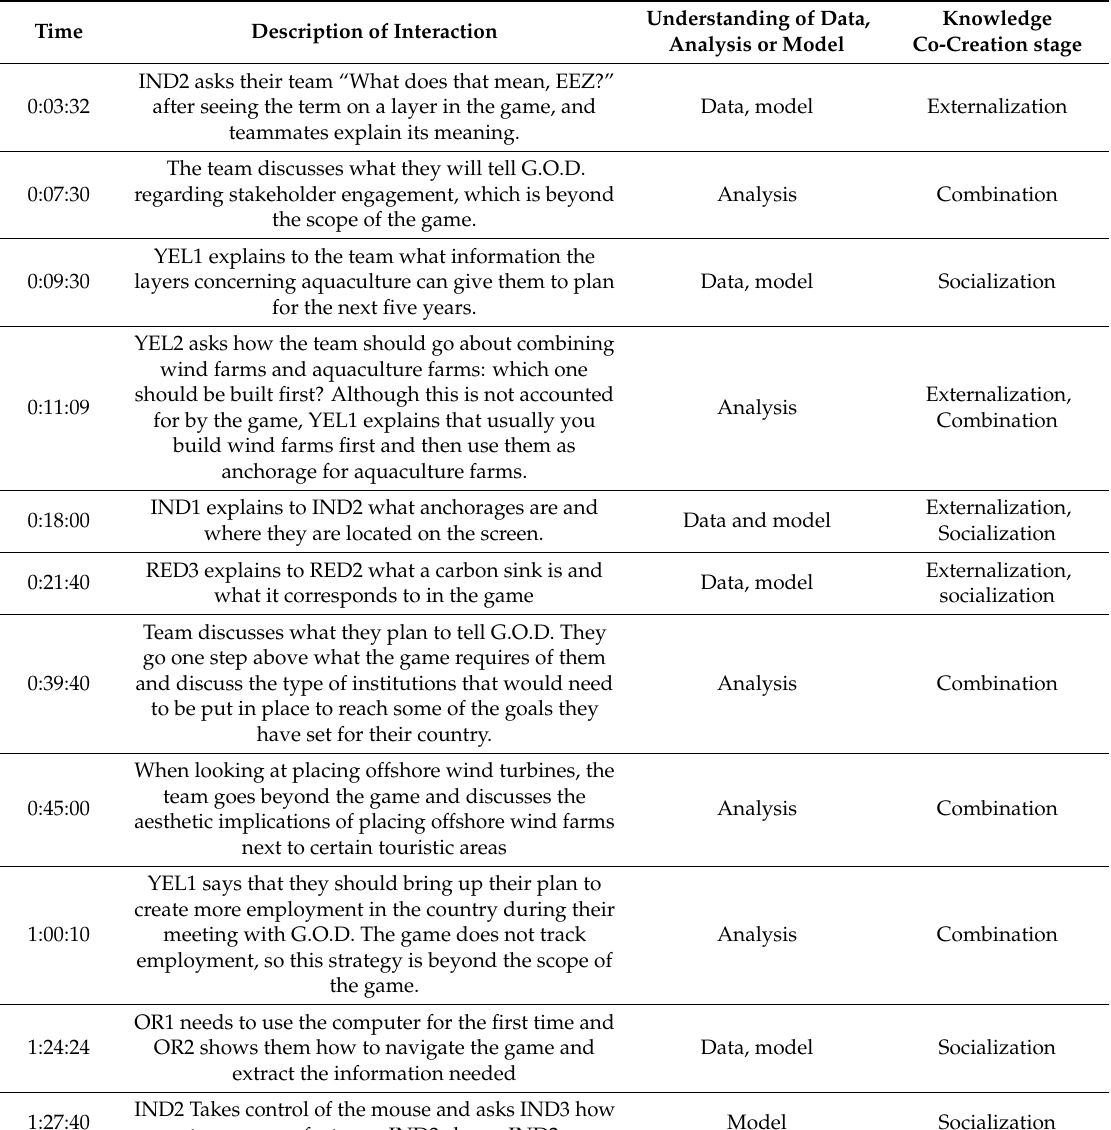
Table 2. Sample of interactions between participants and how these interactions help them understand data, analysis, and models and the corresponding knowledge co-creation stage. Description of Interaction